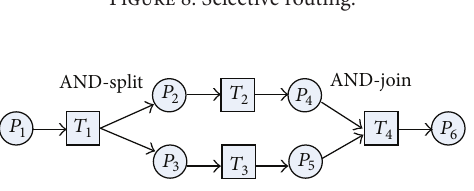
Figure 9: Paralleling routing.